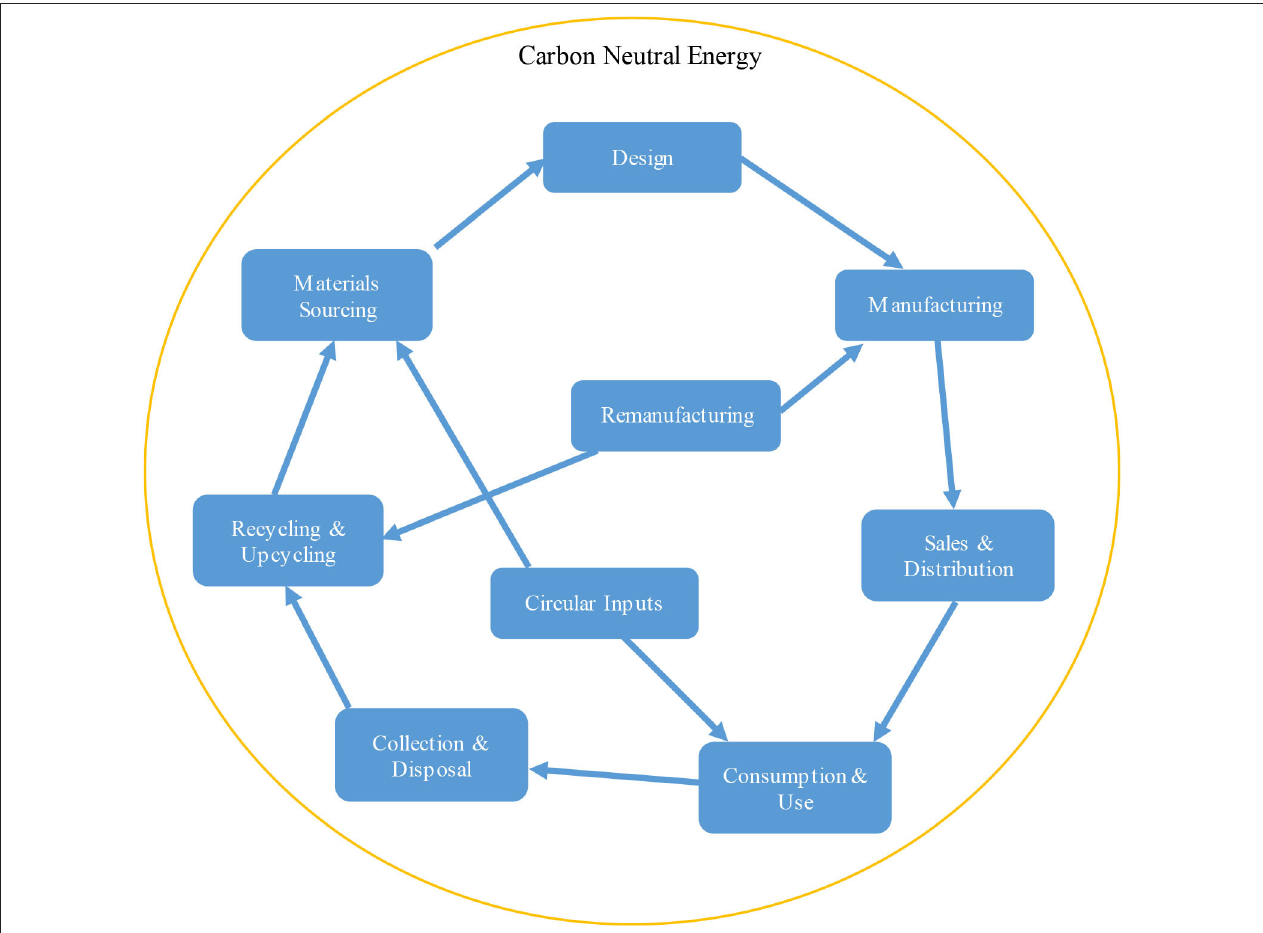
FIGURE 6 | Value chain of the circular economy (original drawing based on concepts from Kalmykova et al.,